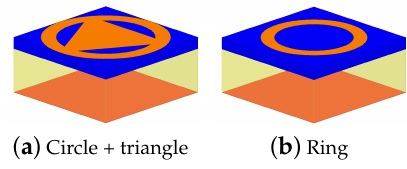
Figure 5. Elements selected for the design.